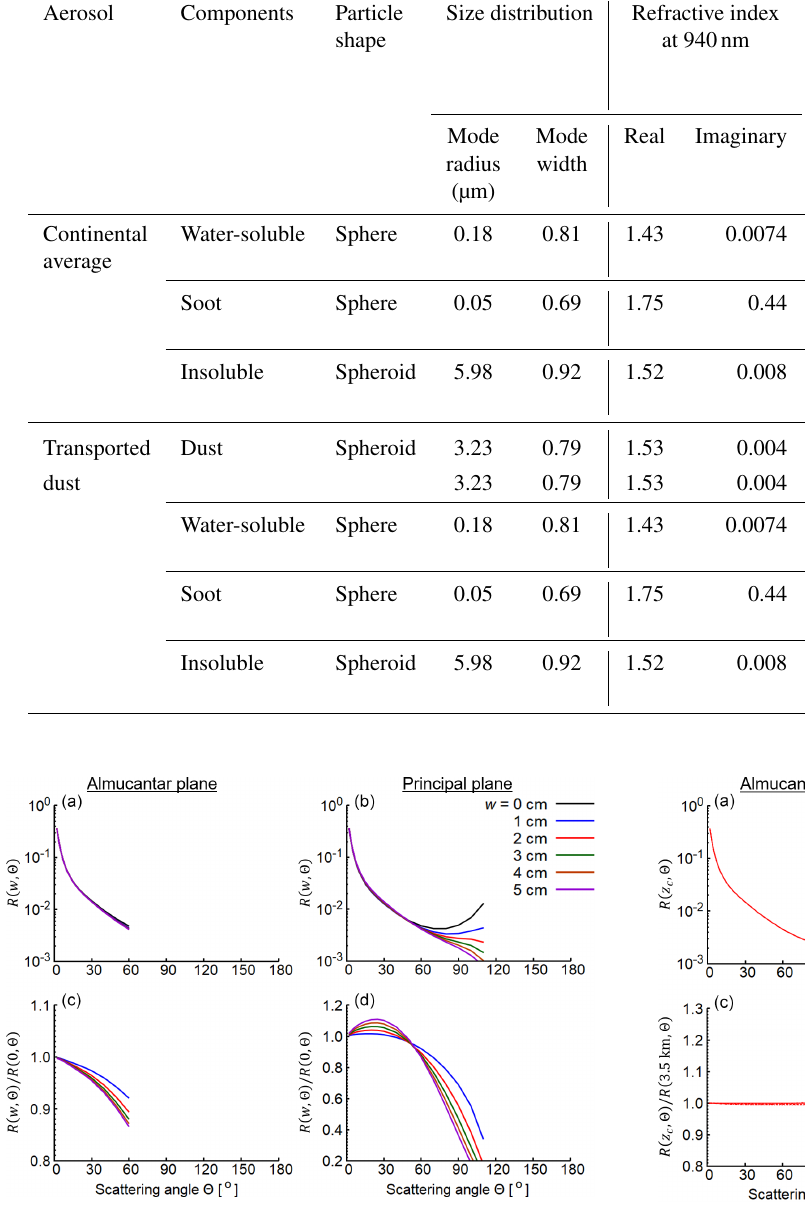
Table 2. Microphysical and optical properties and vertical profiles of aerosol used in sensitivity tests. Aerosol